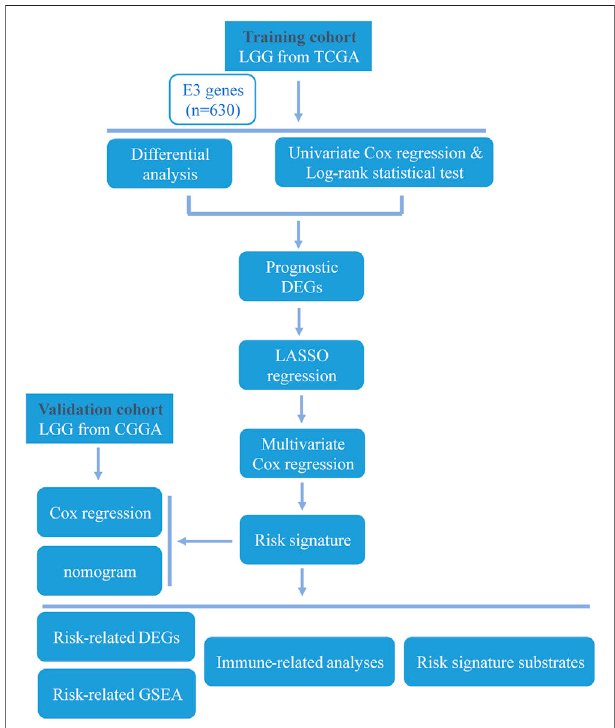
FIGURE 1 | Work fl ow of the